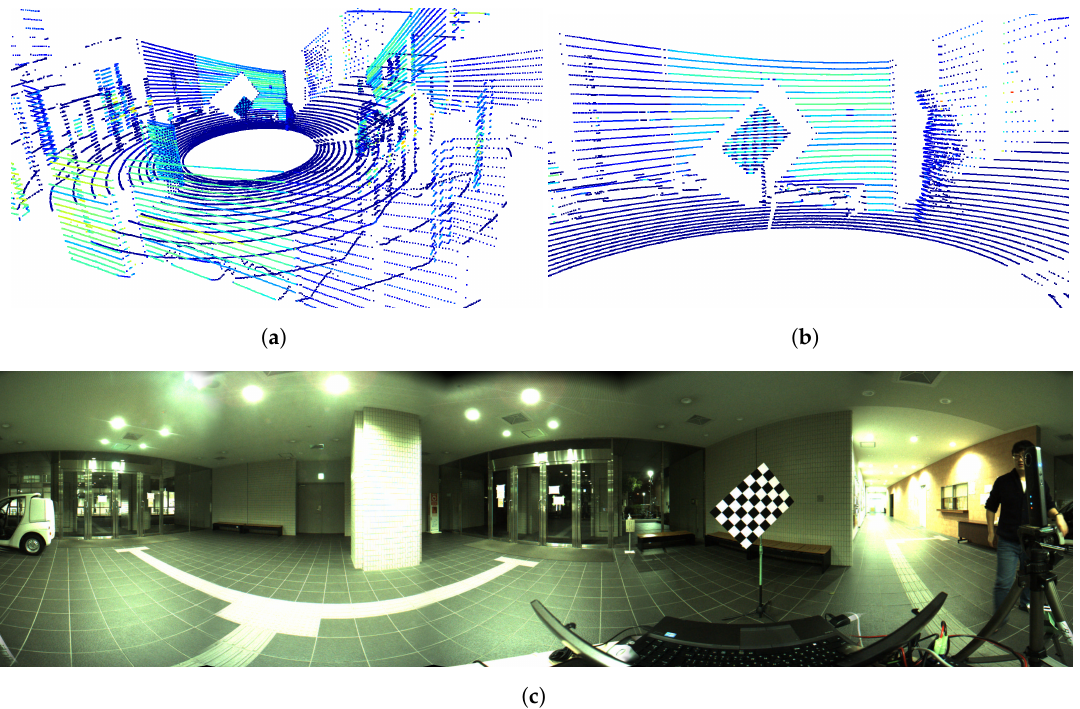
Figure 1. Data from an identical scene captured by the LiDAR sensor and the panoramic camera. ( a ) The points are colored by the reflectance intensity (blue indicates low intensity, red indicates high intensity); ( b ) The zoomed chessboard. We can see the changes in reflection intensity of the point cloud between the white and black patterns; ( c ) The panoramic image of the same